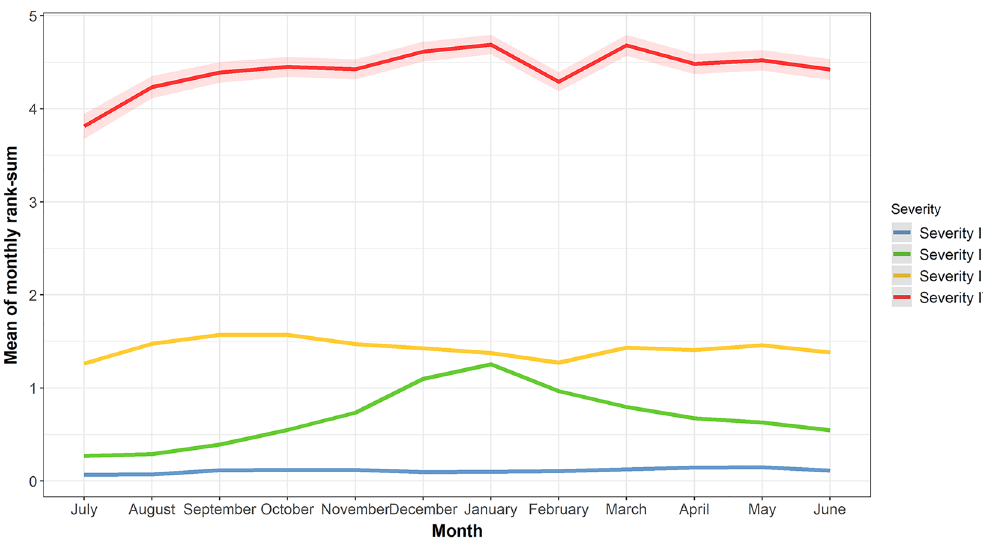
Figure 2. Annual trend of average monthly severity ranks by cluster. The annual severity trends by k-means clustering of 12-month average rank-sum and their 95% confidence intervals.